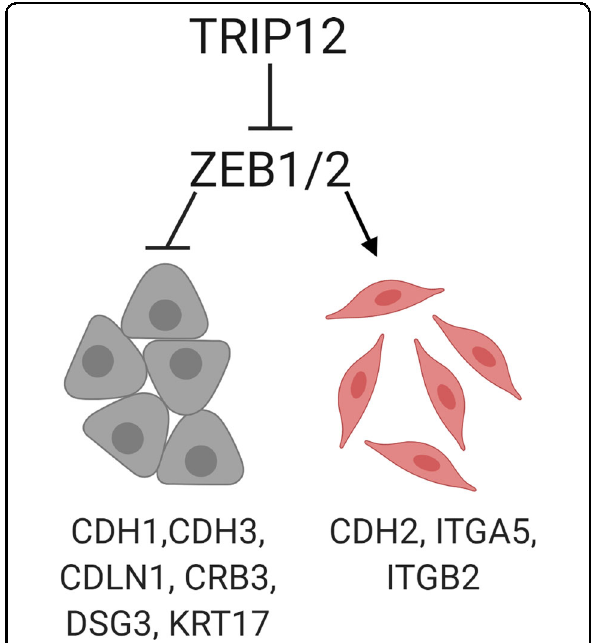
Fig. 6 TRIP12 inhibits EMT through repressing ZEB1/2 regulated cell adhesion gene expression. Image was created using Biorender